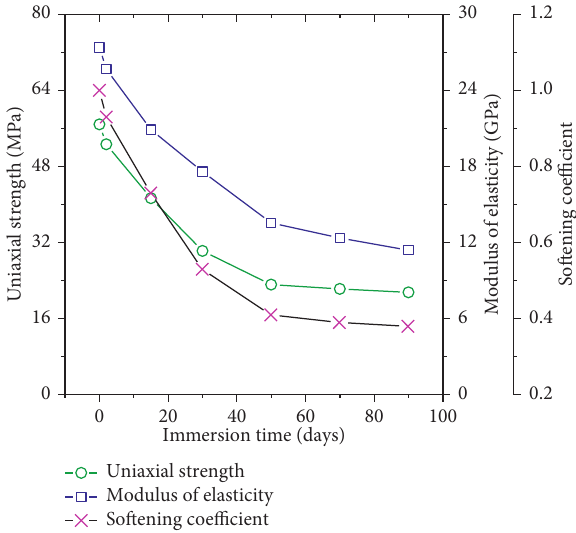
Figure 5: Uniaxial strength, elastic modulus, and softening co- efficient under different immersion times. Figure